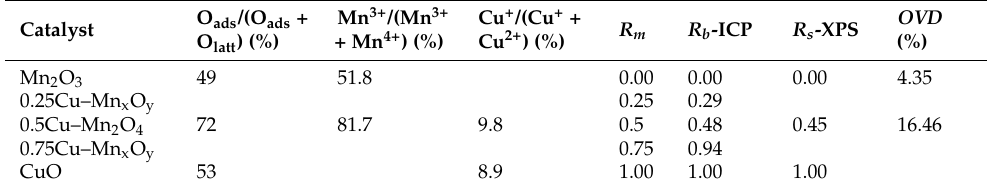
Table 2. Characterization results of each catalyst using XPS, ICP and Raman.